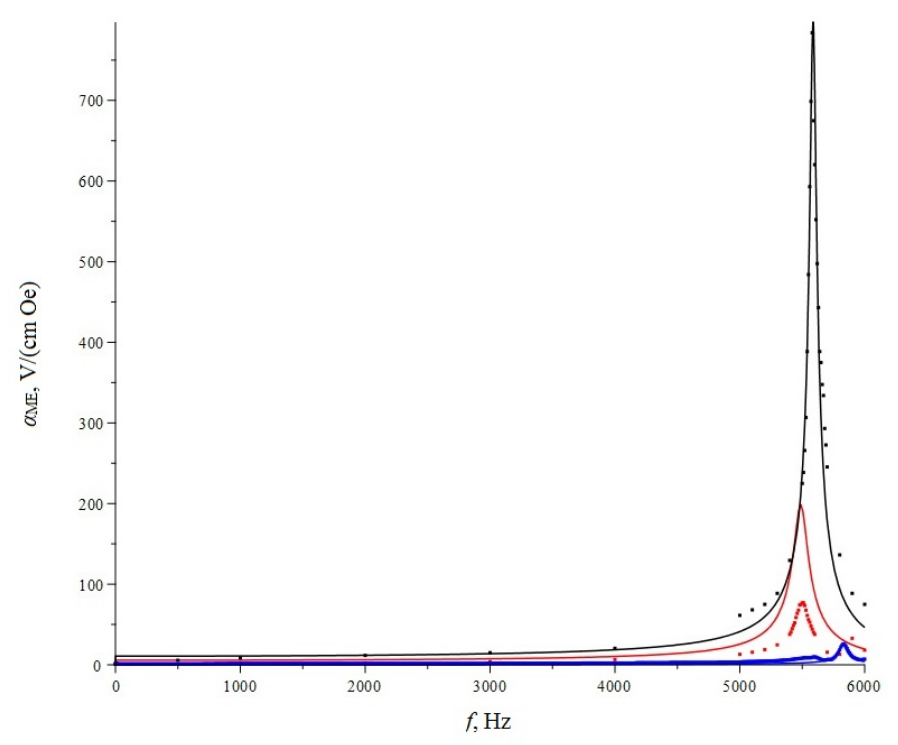
Figure 2. ME coefficient of the multiferroic layered structure based on LiNbO3/Metglas. The solid lines are theoretical curves, and the dots are experimental data (blue—symmetrical; red—asymmetrical with Cu; and black—asymmetrical with Al).